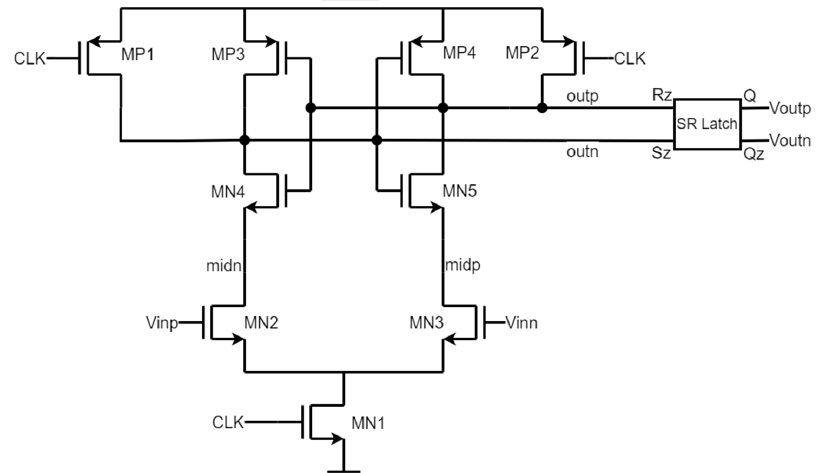
Figure 5. Clocked comparator schematic.